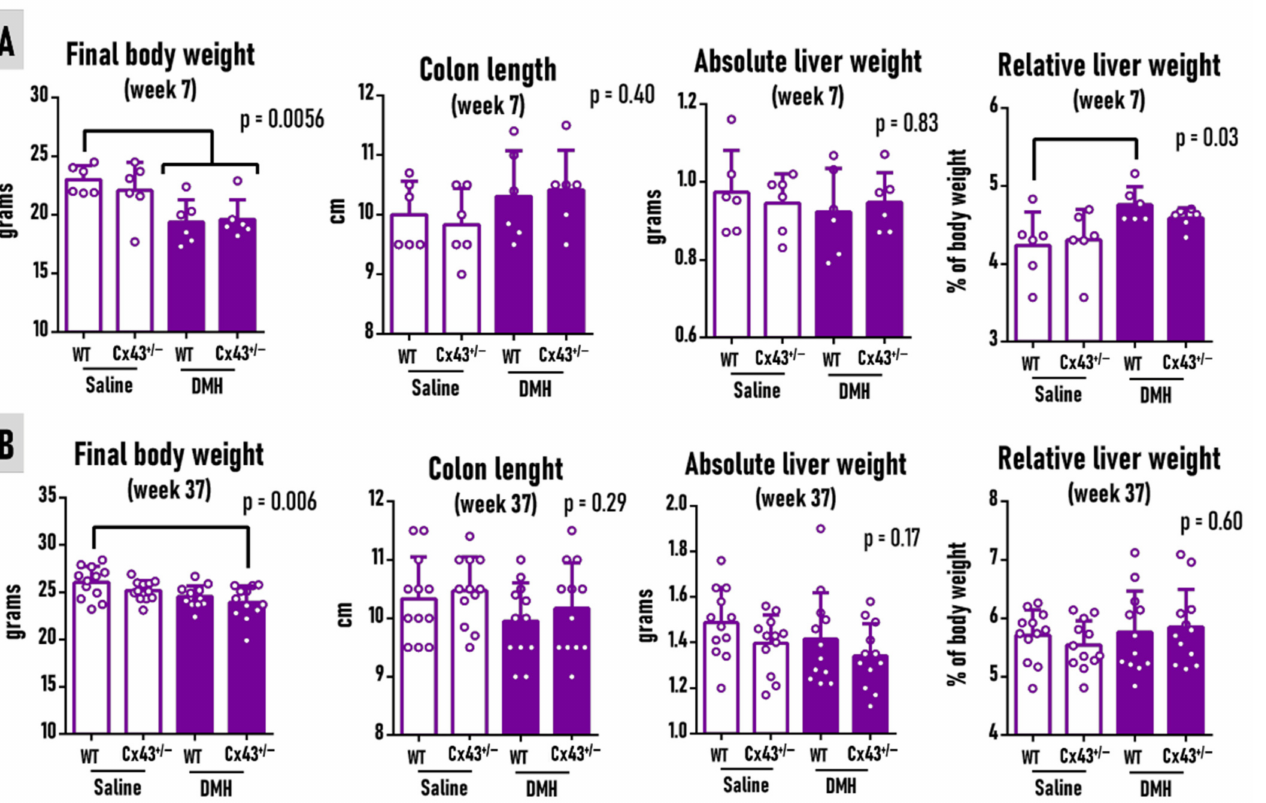
Figure 2. Implications of connexin 43 heterologous deletion (Cx43 +/ − ) on the final body weight, colon length, and absolute and relative liver weights during 1,2-dimethylhidrazine (DMH)-induced colon carcinogenesis in C57BL/6J mice at weeks ( A ) 7 and ( B ) 37. WT: wild-type. n = 6 (week 7) or 12 (week 37) mice/group/genotype. Data were presented as mean + standard deviation and data points. Data were analyzed by the one-way ANOVA and post hoc Tukey test ( p <